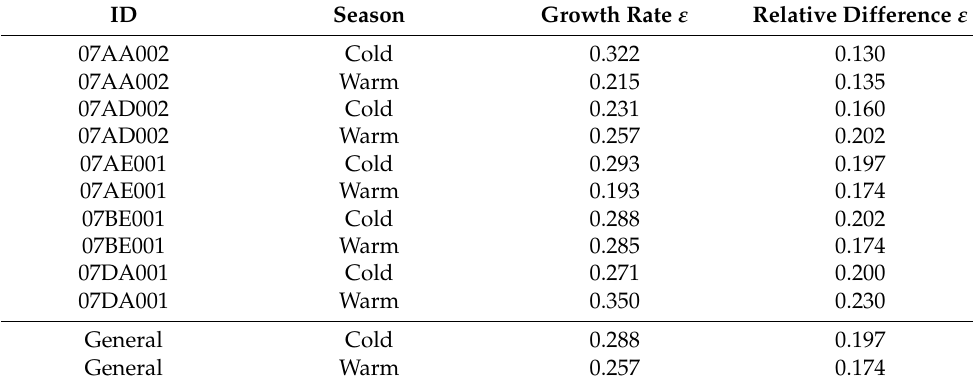
Table 2. ε thresholds separated by cold and warm sets of months (seasons) for each hydrometric station. At the bottom part of the table, general ε thresholds are separated by cold and warm sets of months (seasons) for all hydrometric stations from the ARB region.